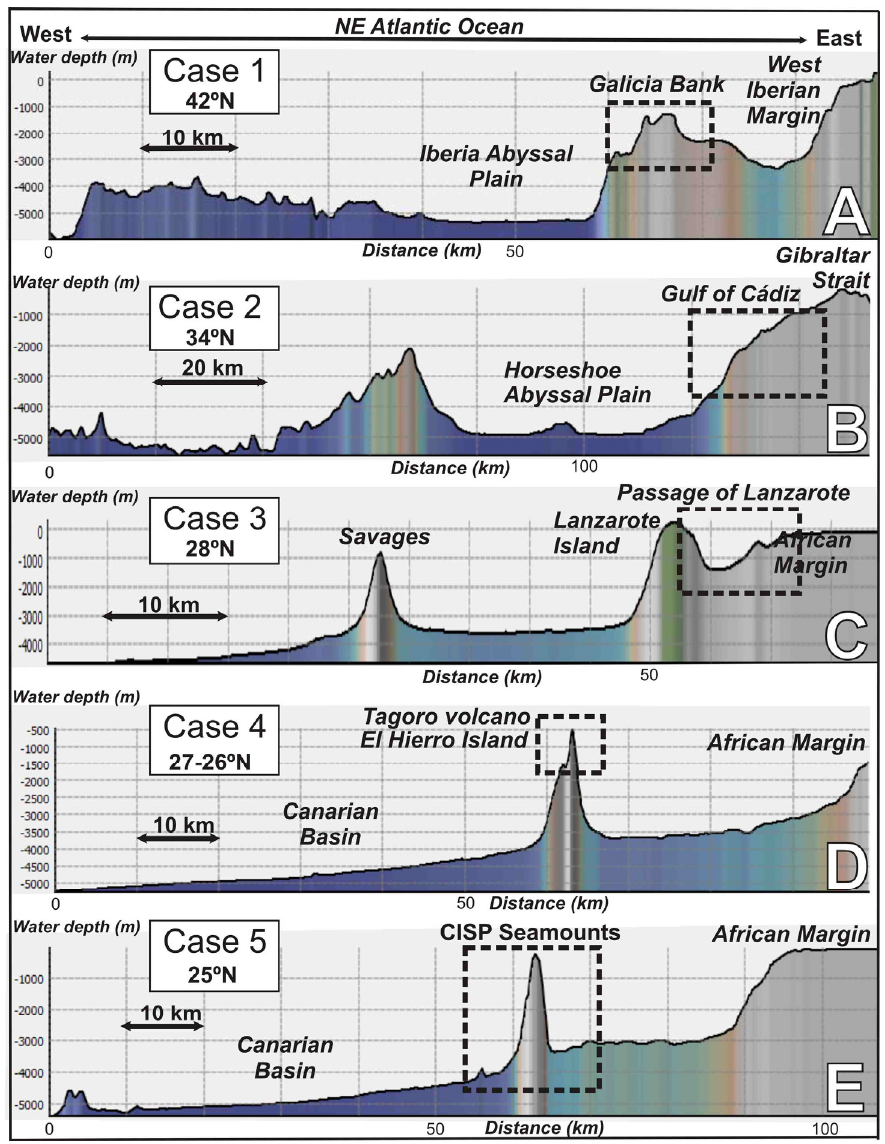
Figure 2. E–W regional bathymetric profiles along the North East and Central Atlantic Ocean showing the morpho-structural context and water depth distribution of the studied areas. ( A ) Galician margin; ( B ) Gulf of Cádiz; ( C ) Passage of Lanzarote (PoL), ( D ) Tagoro volcano, El Hierro Island, and ( E ) Canary Island Seamount Province (CISP). Profiles extracted from bathymetry of the Global Multi-Resolution Topography (GMRT) synthesis data set [29]. See Figure 1 for location.